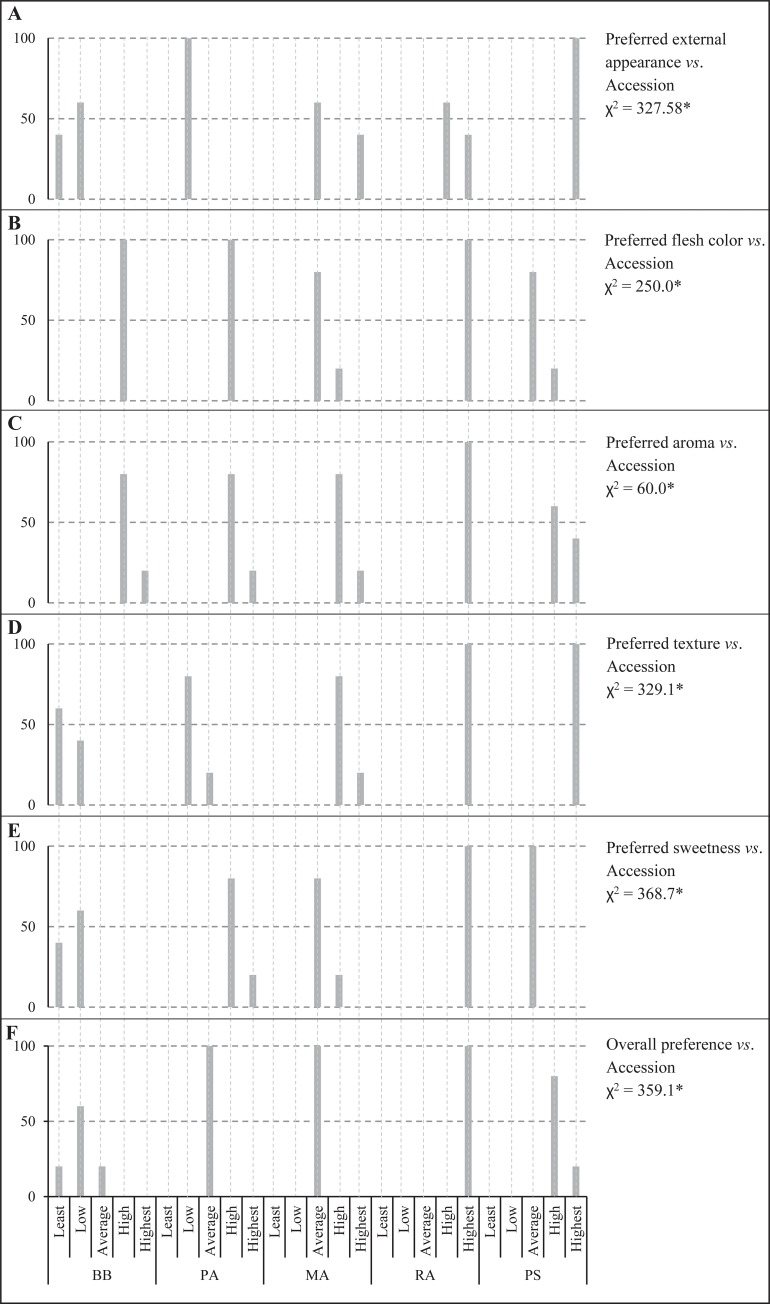
Association analysis for organoleptic parameters and the ripe fruits of the bael accessions.The same scales and values of X and Y axes are shown. The X-axis is shown only once. The vertical grid lines are included to clearly display the preference level classes on the X-axis. Y-axis indicates the percentage respondents.